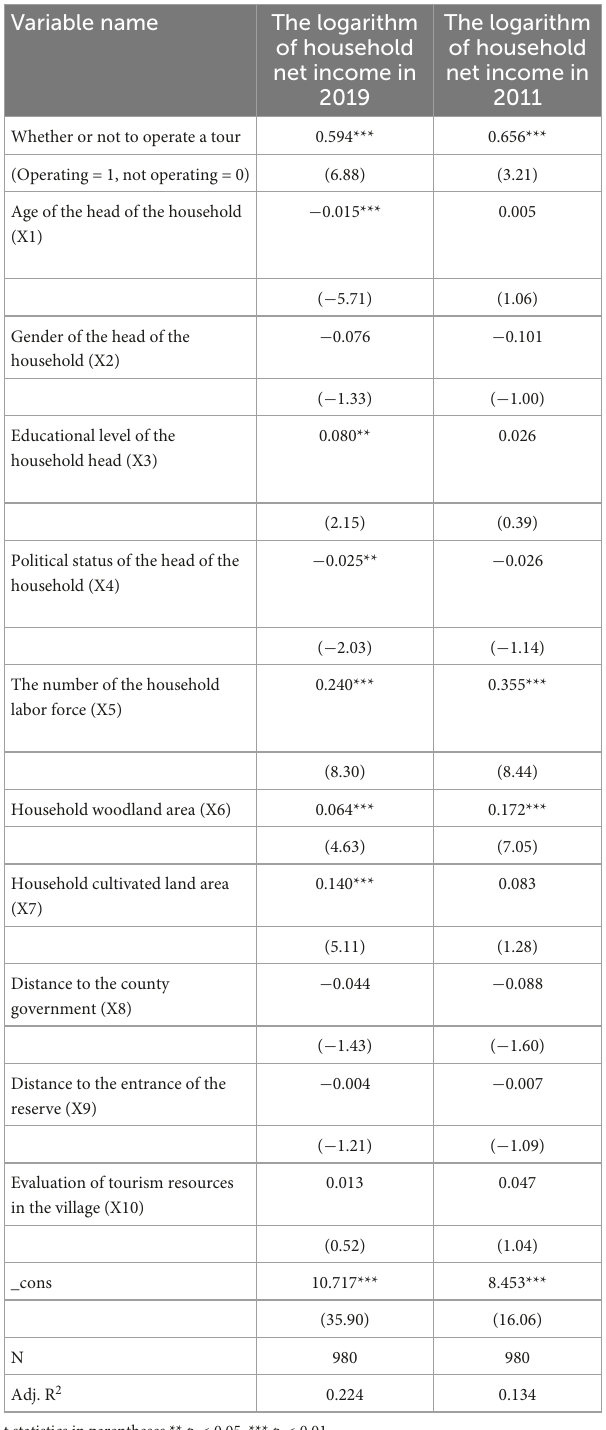
TABLE 2 Regression results of household income effect using OLS model before and after implementation of control